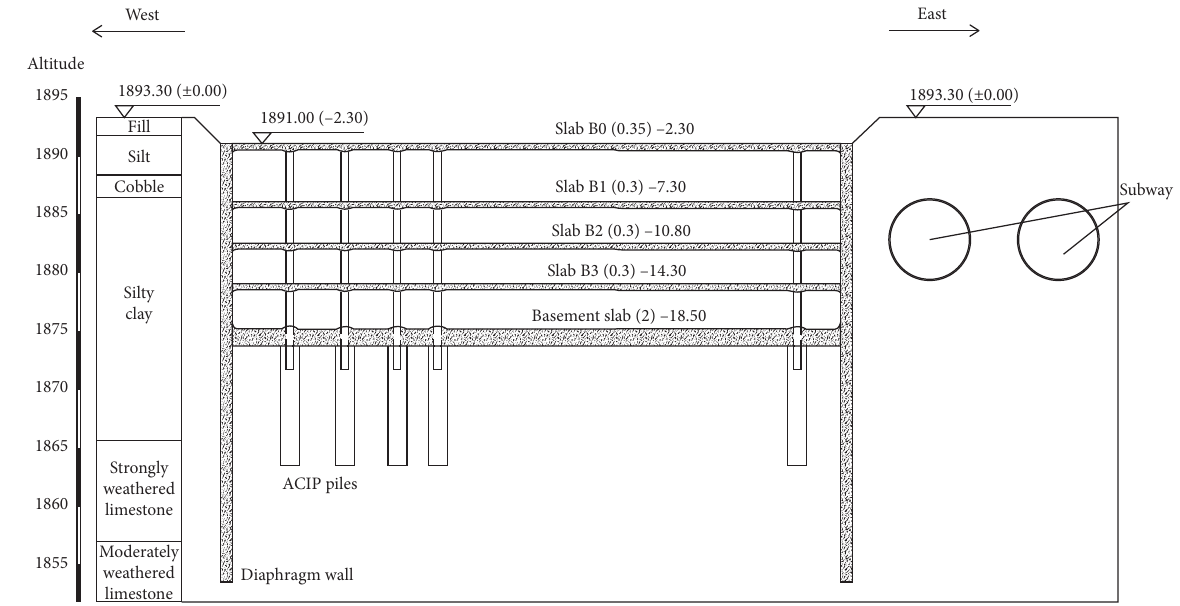
Figure 3: Typical section of A-A’. Table 2: Soil layer